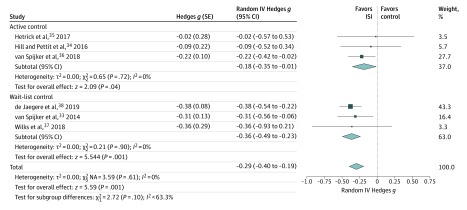
Between-Group Effects of Internet-Based Self-help Interventions (ISIs) on Suicidal Ideation Post InterventionNegative values indicate lower suicidal ideation in the intervention group compared with controls. Size of markers indicates weight. IV indicates inverse variance; and NA, not applicable.